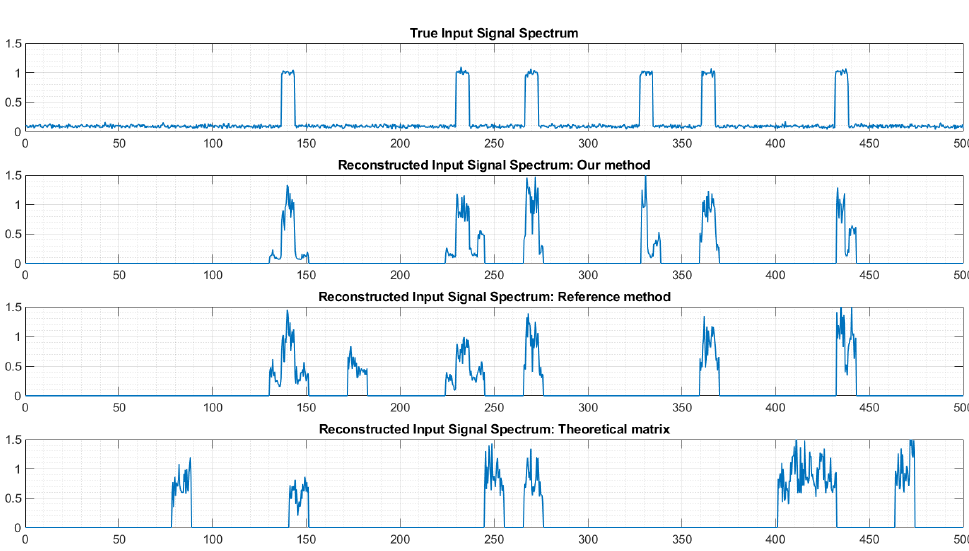
Figure 22. Example of spectrum reconstruction with 6 transmitters. The horizontal axes are frequen- cies, labeled in